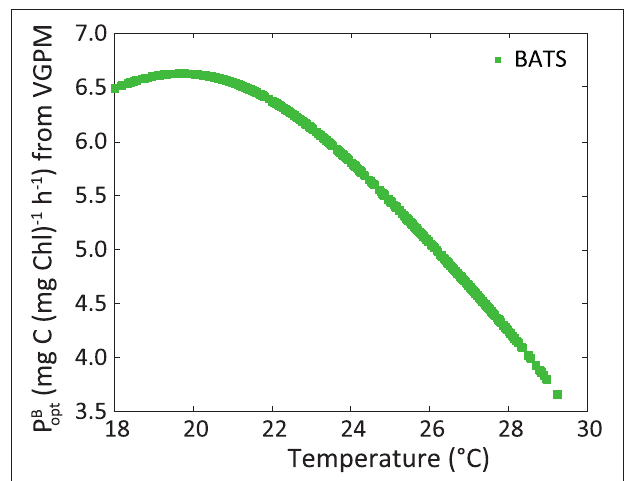
FIGURE 11 | Maximum C fixation rate within a water column [P B opt , in mg C (mg Chl) − 1 h − 1 ] following VGPM, as a function of SST sat at